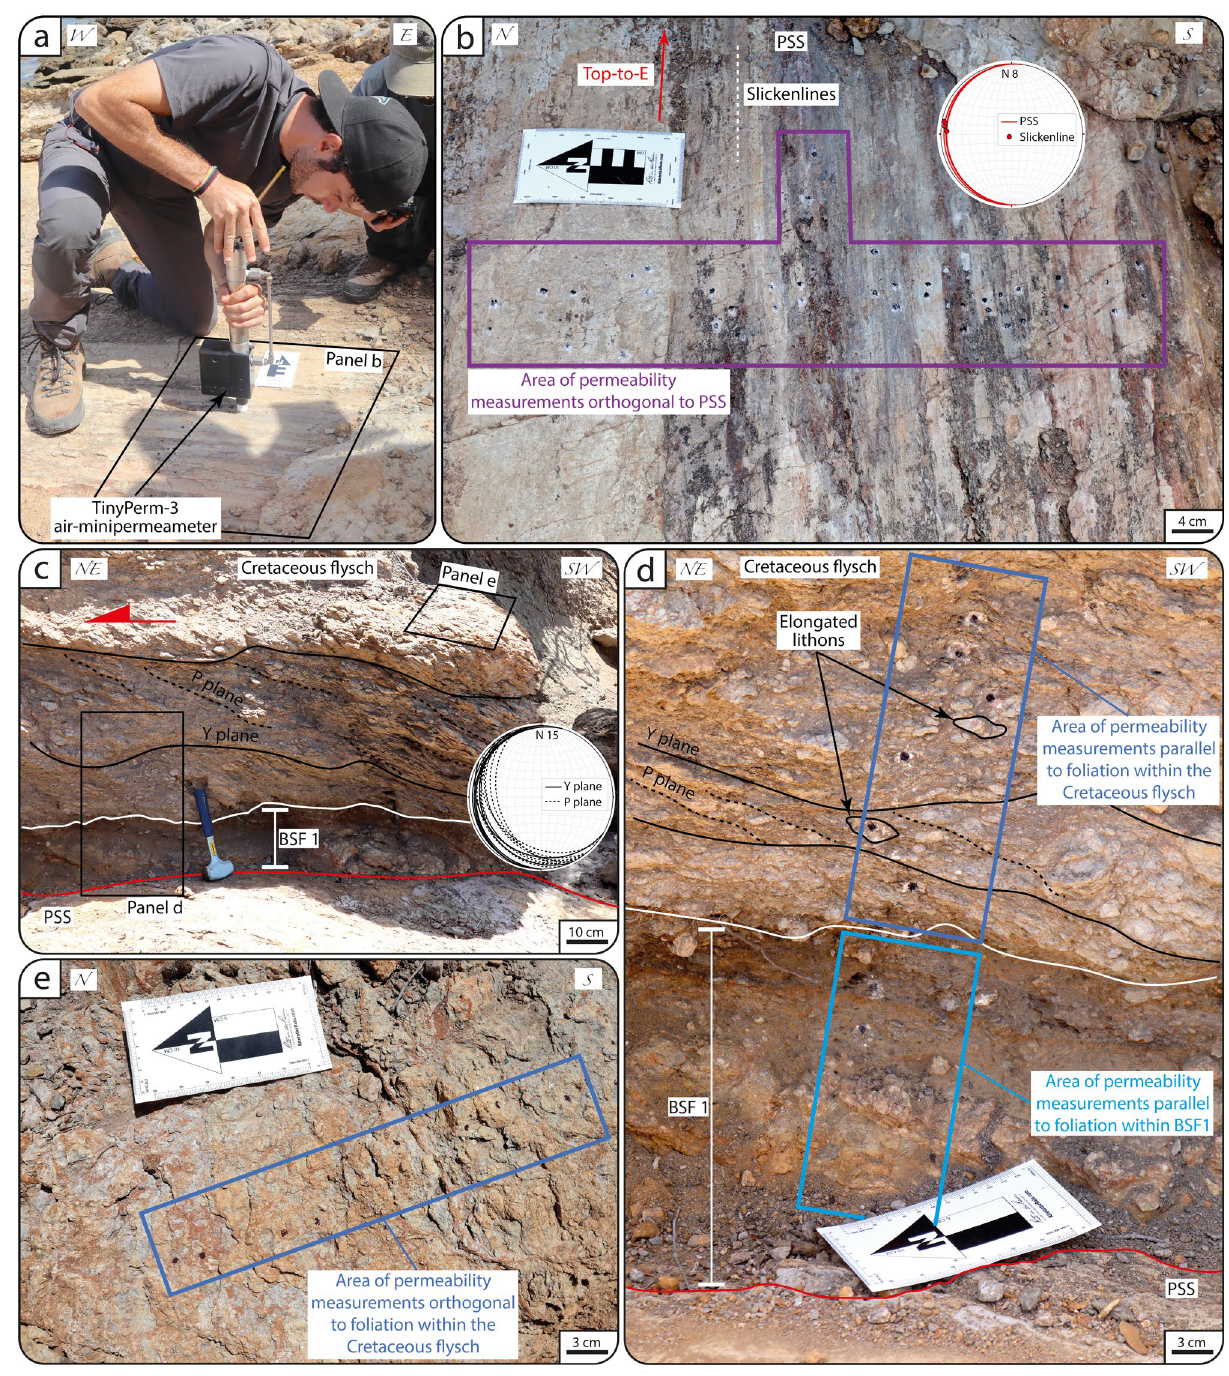
Figure 4. ( a ) In-situ outcrop permeability measurement by TinyPerm-3 air-minipermeametry orthogonal to the PSS of the ZF. ( b ) Striated PSS of the ZF accommodating top-to-E kinematics. The Schmidt net (lower hemisphere projection) plots the orientation of the PSS and of the relative slickenlines. ( c ) PSS, overlying BSF 1 and Cretaceous flysch containing Y-P tectonites the attitude of which is shown in the Schmidt net (lower hemisphere projection) in ( c ). ( d ) Detail of BSF 1 and Cretaceous flysch characterized by elongated lithons embedded within the foliated matrix. ( e ) Detail of the area of permeability measurements collected orthogonal to Y-P